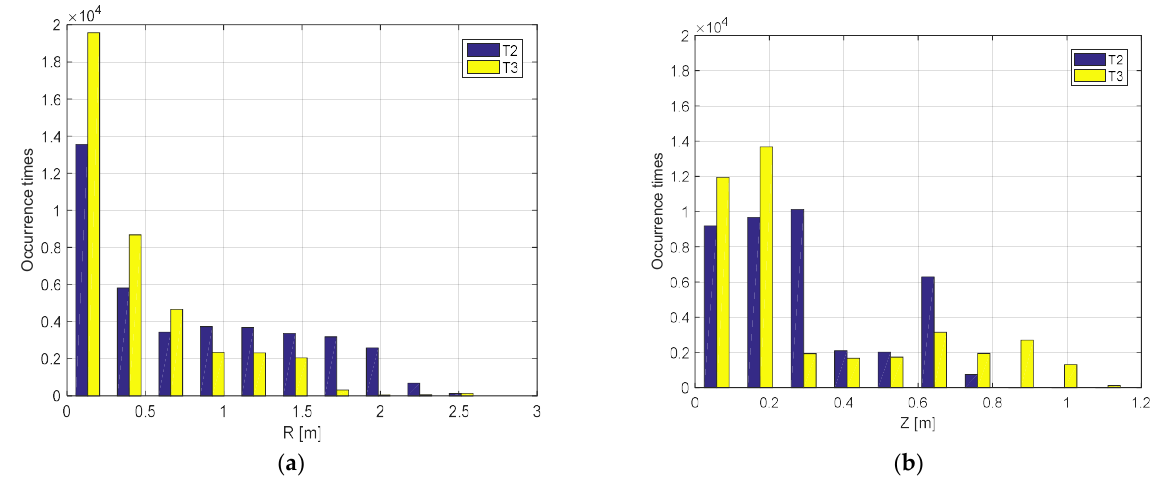
Figure 14. Histogram comparison of the displacement of foundation with T2 and T3. ( a ) In-plane displacement, ( b ) out-of-plane displacement.